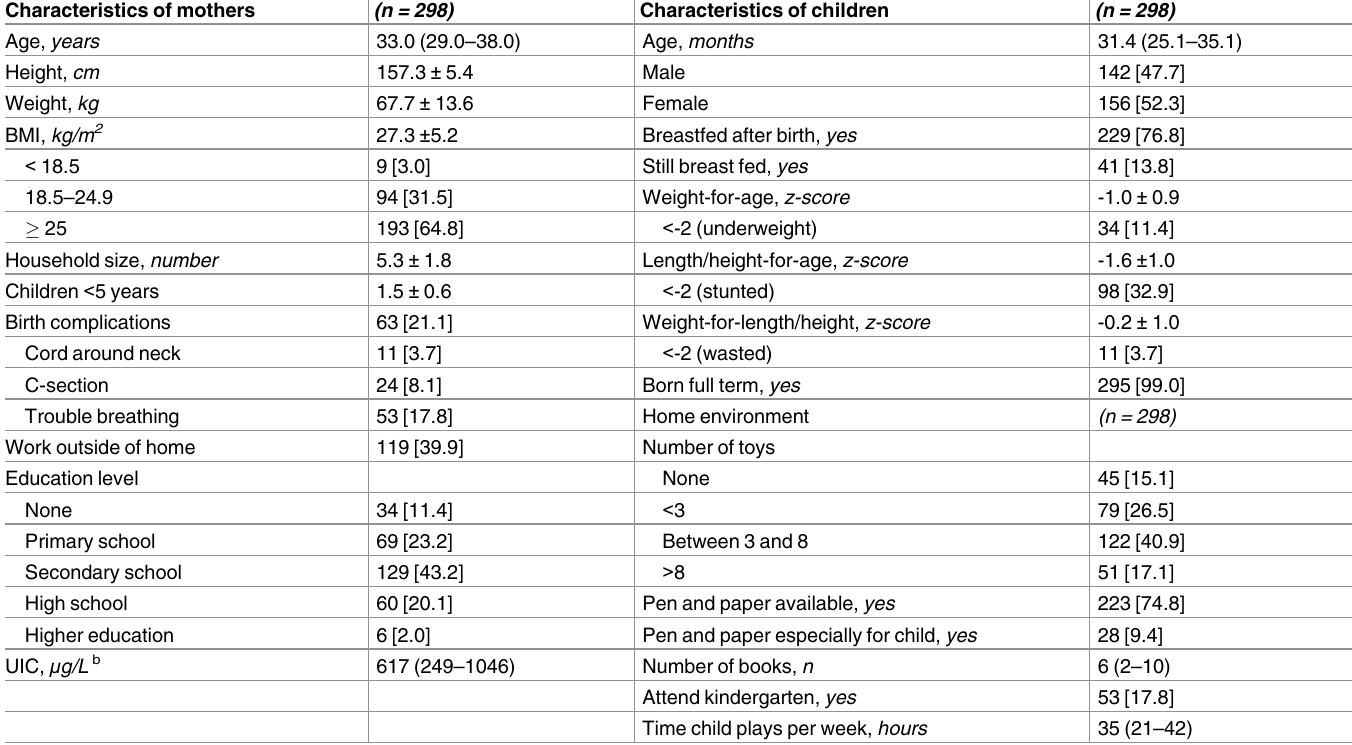
Table 1. Characteristics of the mothers,children and home environment in a study describing the association between thyroid function and devel- opment in young children a . Characteristics of